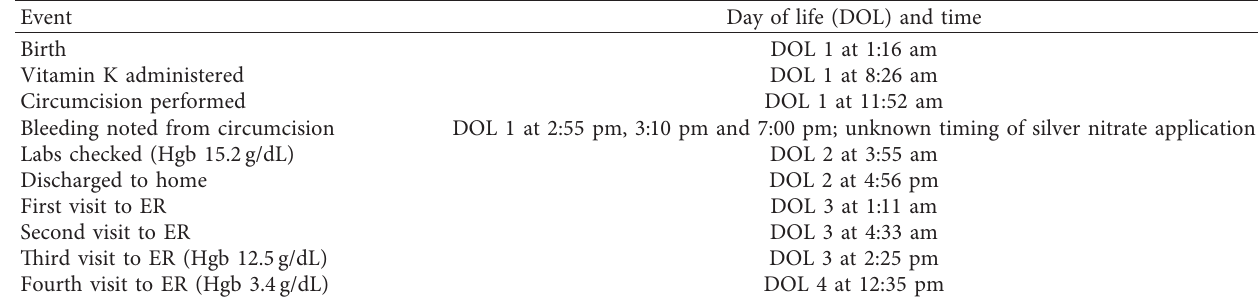
Table 1: Chronology of care.